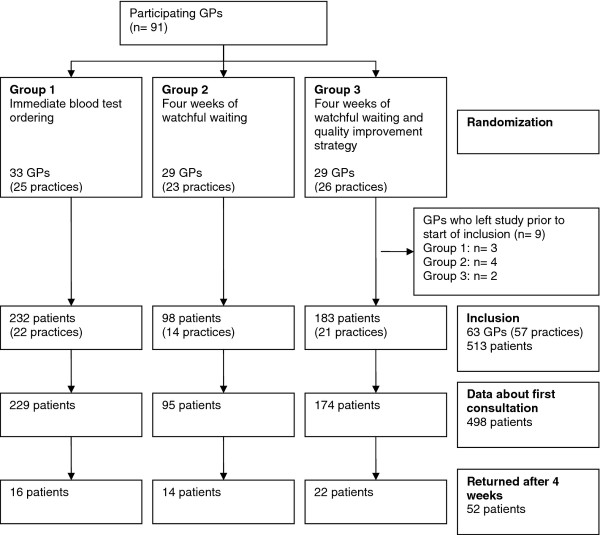
Participant flow.